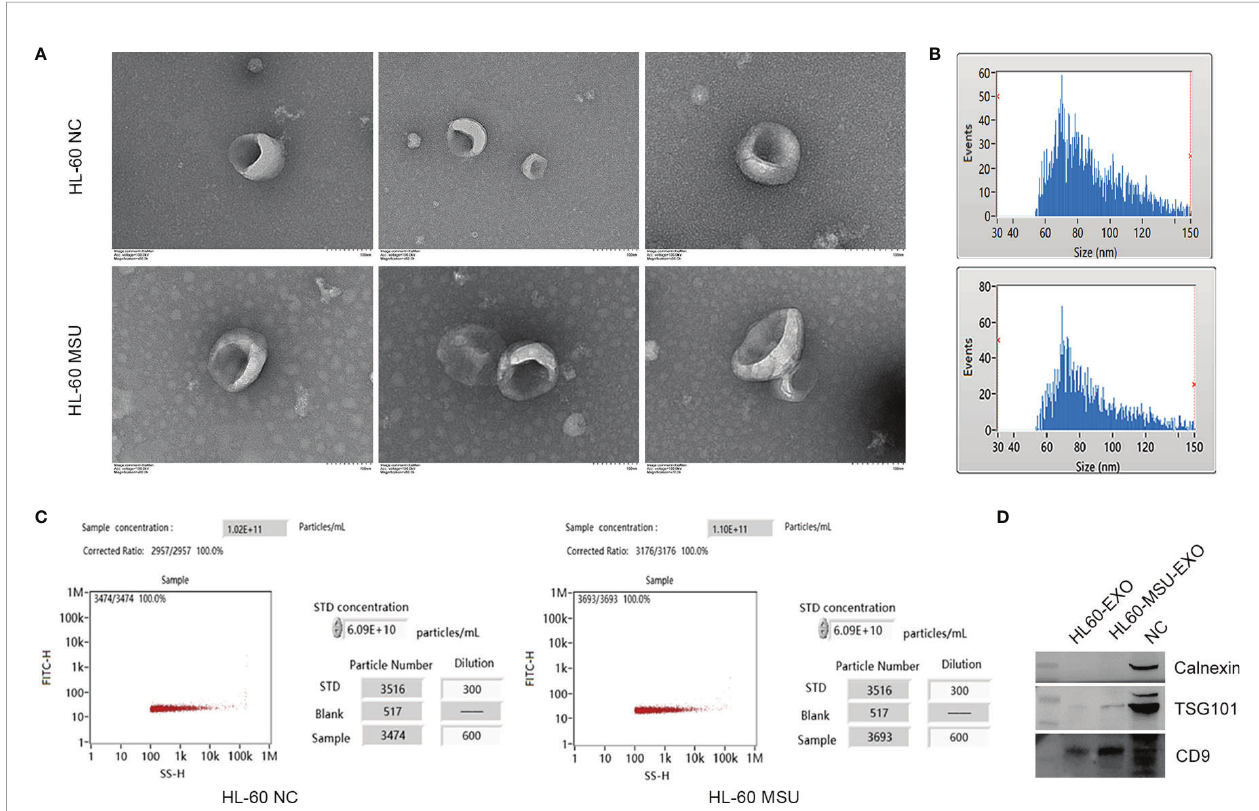
FIGURE 1 | Characteristics of neutrophil-derived exosomes. (A) The size and shape of exosomes are observed by transmission electron microscopy (TEM). The size of exosomes ranges from 60 to 150 nm. (B) Schematically illustration of the distribution of exosome particle size. The particle size was assessed by nanoparticle tracking analysis (NTA). HL-60 NC: Median, 80.25 nm; Mean, 86.01 nm; SD, 21.05 nm; HL-60 MSU: Median, 82.25 nm; Mean, 87.69 nm; SD, 21.42 nm. (C) Schematically illustration of exosome particle concentration. (D) The exosome markers of CD9 and TSG101 are expressed obviously, and there is no expression of calnexin according to western blotting